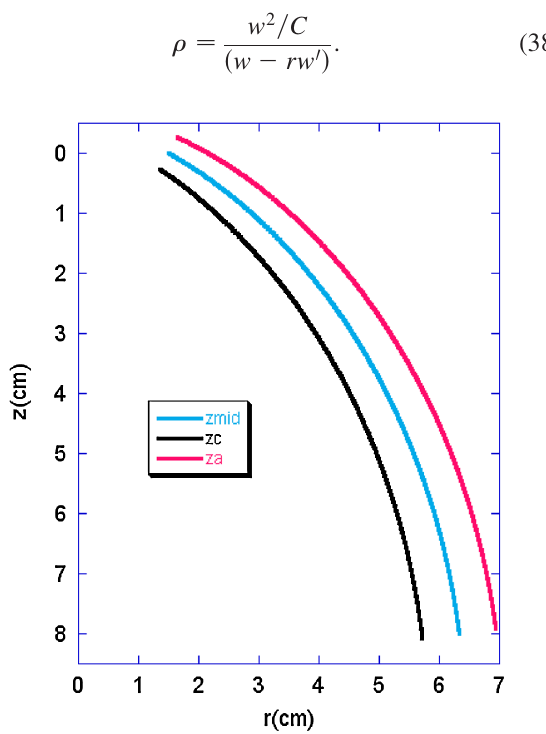
FIG. 6. (Color) Optimal TL, gap varies as r 1 = 2 from 0.6 to 1.2 cm. Electrode and midgap curves (cathode in black, anode in red, midgap in blue) for a TL whose gap varies as the square ¼ 0 : 6 cm at the inner end point, r root of radius, being w 1 ¼ 0 cm , and w ¼ 1 : 2 cm at the outer end point r 1 : 5 cm , z 1 2 ¼ l z ¼ 8 cm . As explained in the text this curve was 6 cm , z 2 obtained by numerical integration of Eq. (34), varying the (cid:1) defined in Eq. (39) until the resulting optimal z ð r Þ goes through the indicated end points. The vacuum inductance of this optimal TL is 4.4